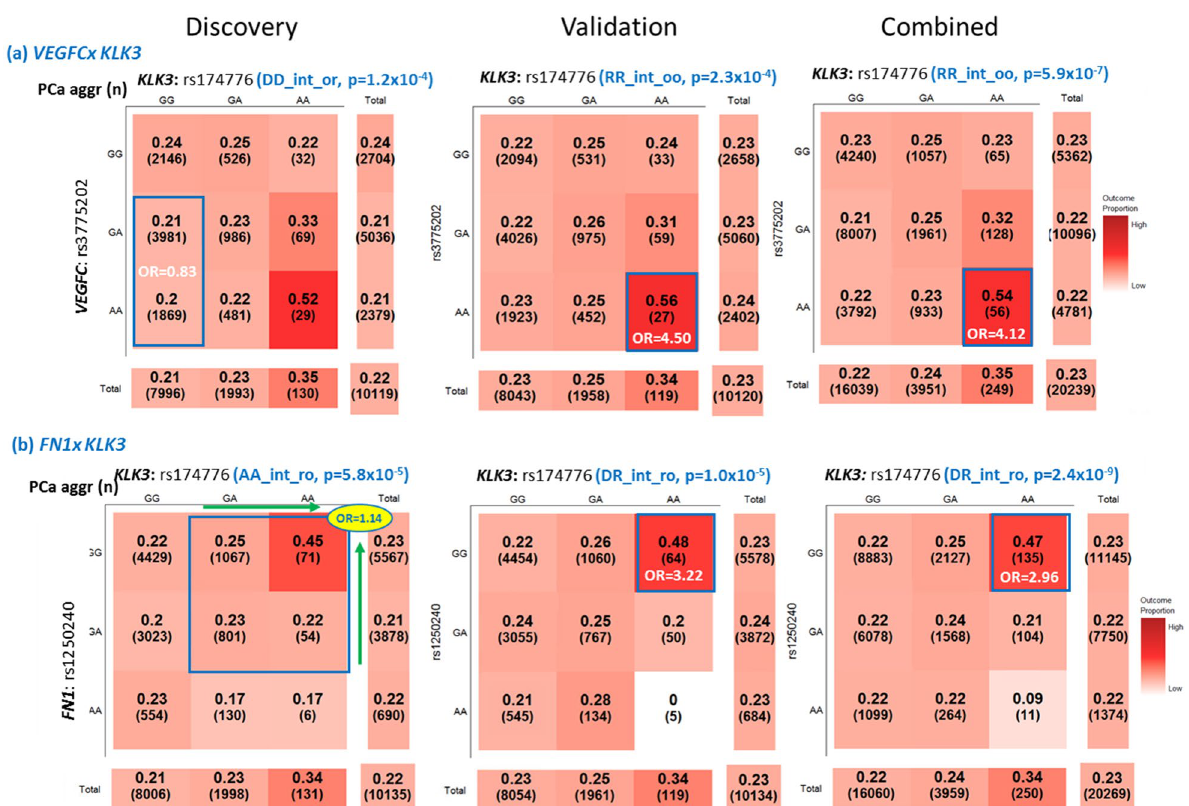
Figure 3. Selected SNP–SNP interactions with a large effect size associated with prostate cancer aggressiveness. Note: PCa aggr (n): prevalence of prostate cancer aggressiveness (sample size in the genotype combination); SNP–SNP Interaction Pattern: “(SNP1 mode)(SNP2 mode) _int_ (SNP1 code)(SNP2 code)”; OR: odds ratio of PCa aggressiveness adjusted for study sites and 6 principal components for population stratification. The darker color indicates a higher risk of prostate cancer aggressiveness. A additive inheritance mode, aggr aggressiveness, D dominant inheritance mode, o original coding based on the minor allele, OR odds ratio, PCa prostate cancer, R recessive inheritance mode, r reverse code direction, SNP single-nucleotide polymorphism. These heat tables were generated using the plot3by3 function in the SIPI R